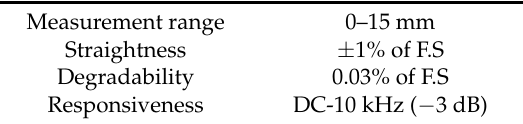
Table 2. The specification of A/D converter and D/A converter.